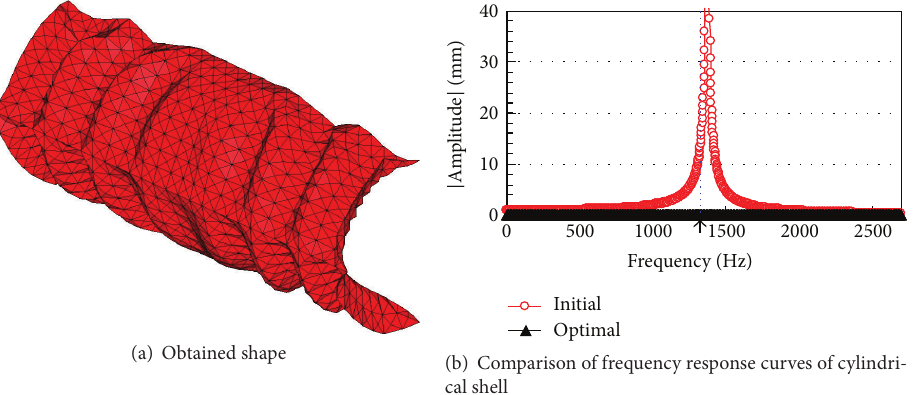
Figure 8: Optimization results for 𝑢 = 0.001 max (𝑢 init ) of half-cylindrical shell.